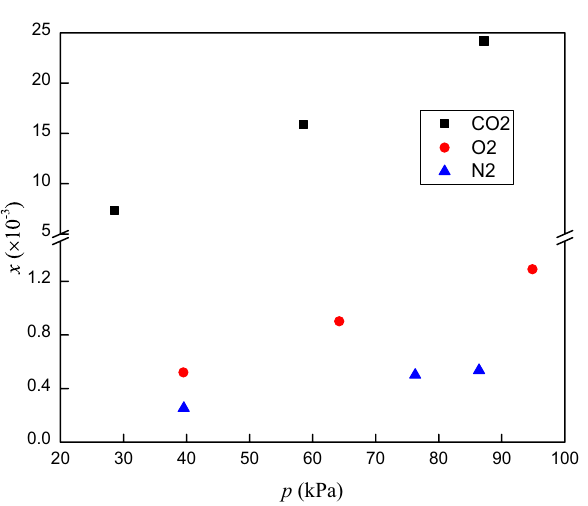
Figure 7. Solubility (mole fraction) of CO 2 , O 2 and N 2 in RP5 at 293.15